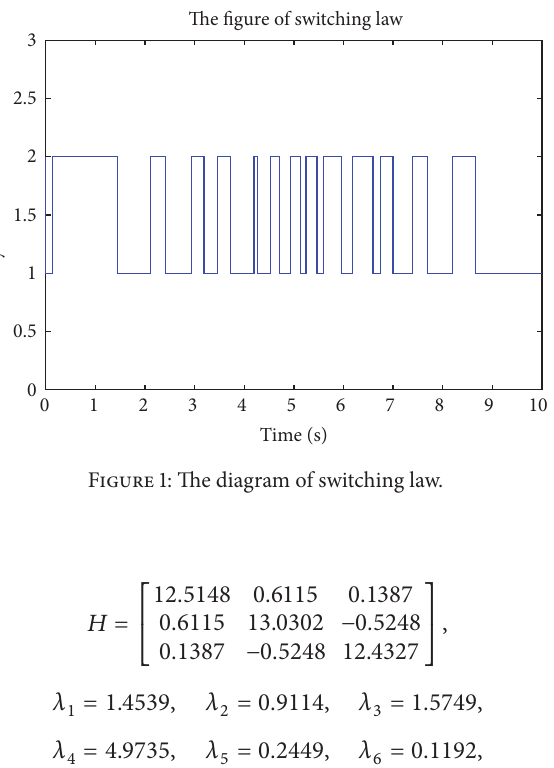
The figure of x T (t)x(t)